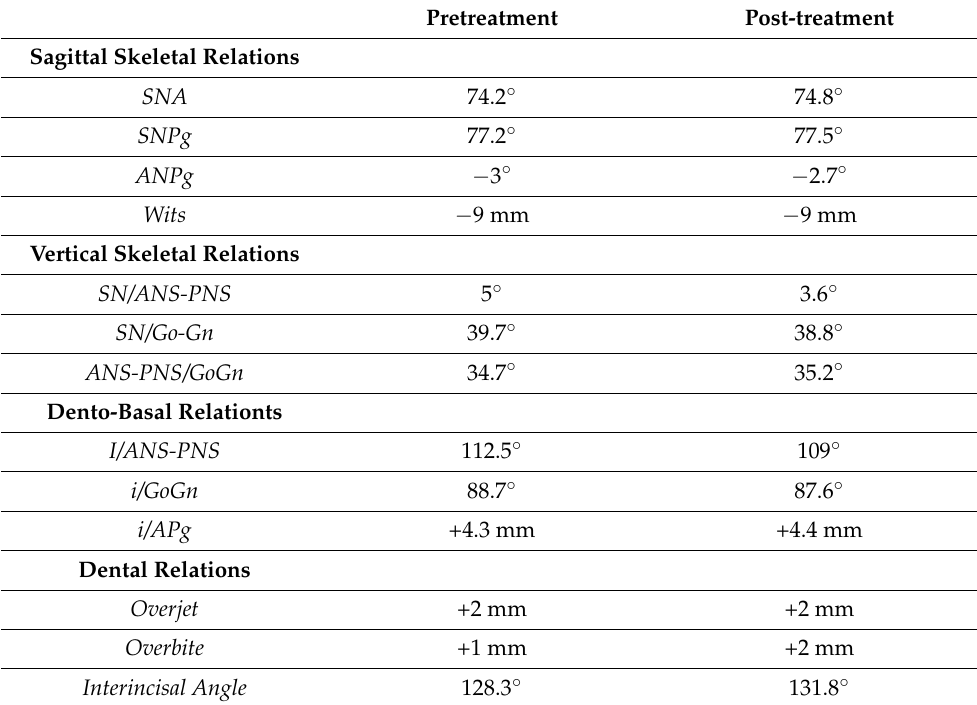
Table 1. Cephalometric Analysis.